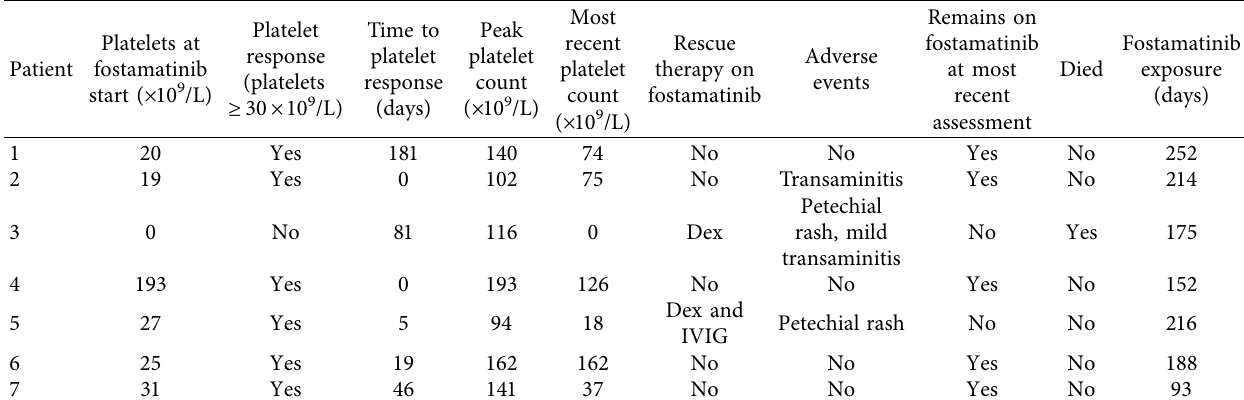
Table 2: Characteristics on fostamatinib.